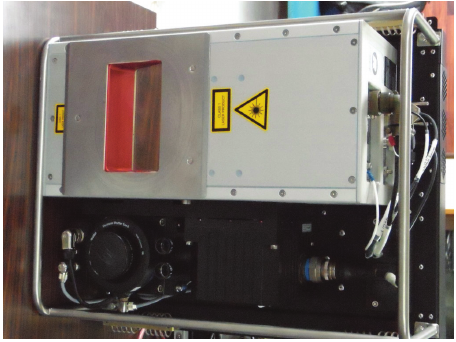
Fig 4. Red Relief Image Map (Aokigahara:West of